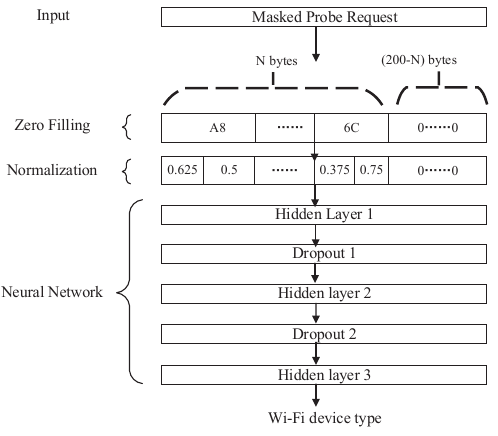
Figure 3. Construction of neural